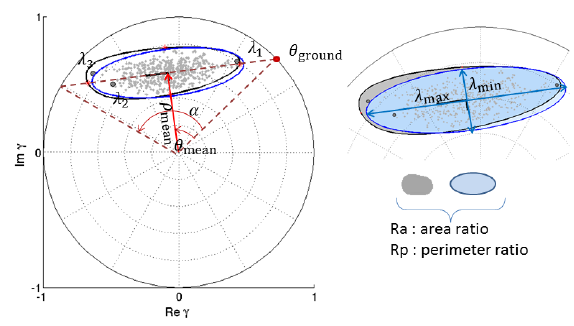
Figure 5. Visualization of the main coherence shape parameters. λ 1 , λ 2 , λ 3 are the eigen values of matrix A (see Figure